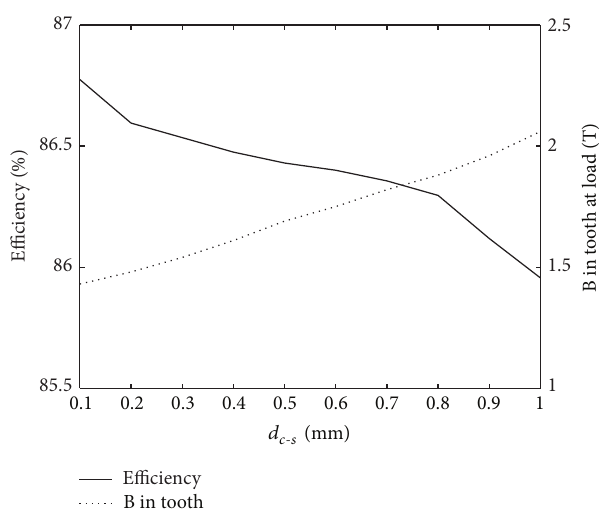
Figure 6: Efficiency and B-field in tooth at nominal load for varying distance between cable and